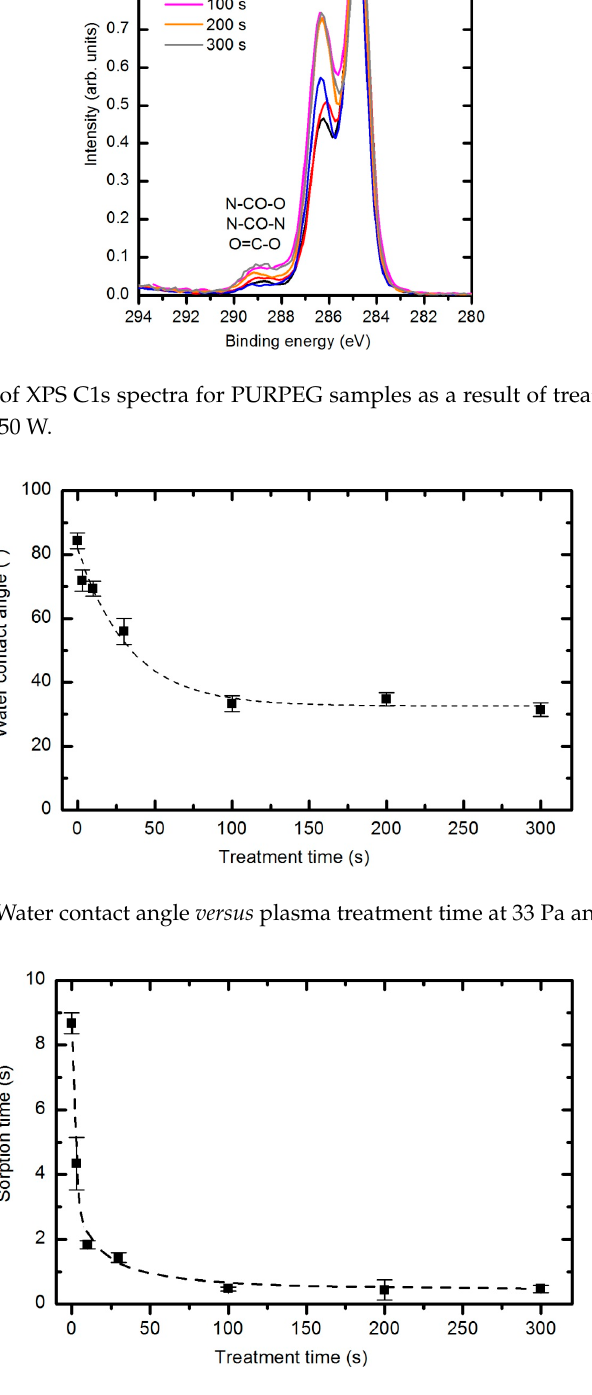
Figure 20. Absorption time of a water droplet versus plasma treatment time at 33 Pa and 150 W.